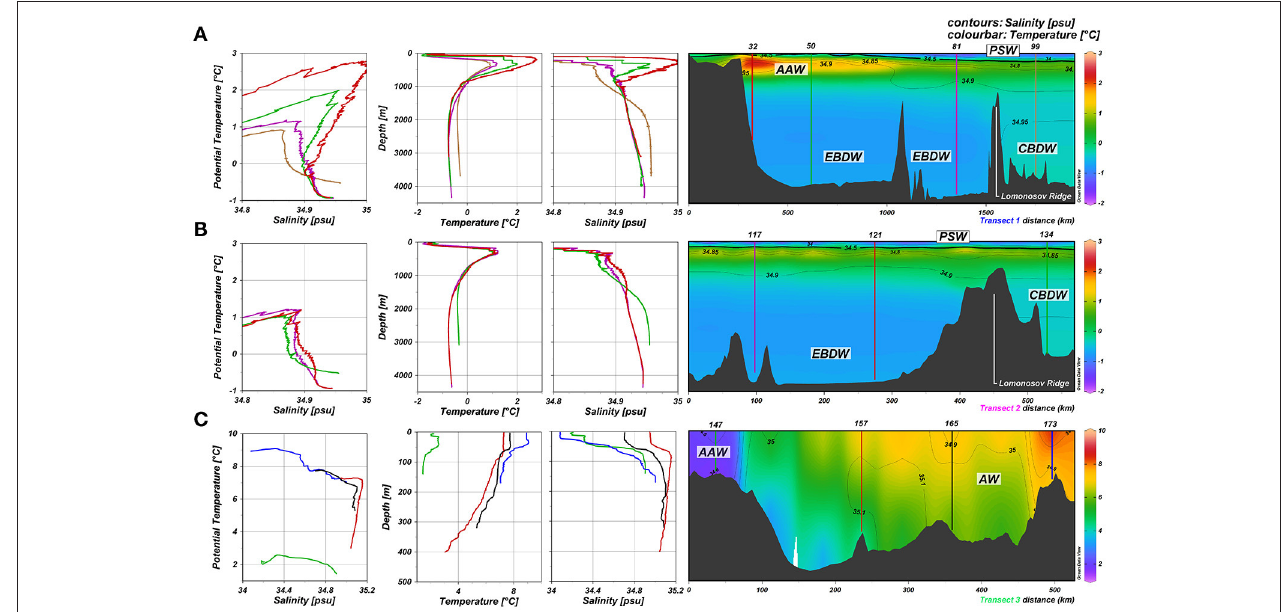
FIGURE 2 | TS profiles and section plots of Transects 1–3 ( A–C ; Rabe et al., 2016). At the left side property-property plots show potential temperature vs. salinity (T-S, left) followed by depth profiles of potential temperature (middle) and salinity (right) for those stations indicated in the section plots of potential temperature (color bar) and salinity (contours) of the transects (far right). Station numbers are indicated above the transects. Polar Surface Water (PSW), Eurasian Basin Deep Water (EBDW), Canadian Basin Deep Water (CBDW) Atlantic Water (AW), and Arctic Atlantic Water (AAW) are indicated in the temperature sections. T-S plots are scaled to detail small-scale variations to help characterize water masses after Rudels (2010, 2012). Salinities of 34.5 are indicated in a thicker contour denoting the PSW border (Rudels, 2010). Note the difference in scale for the transect 3 color